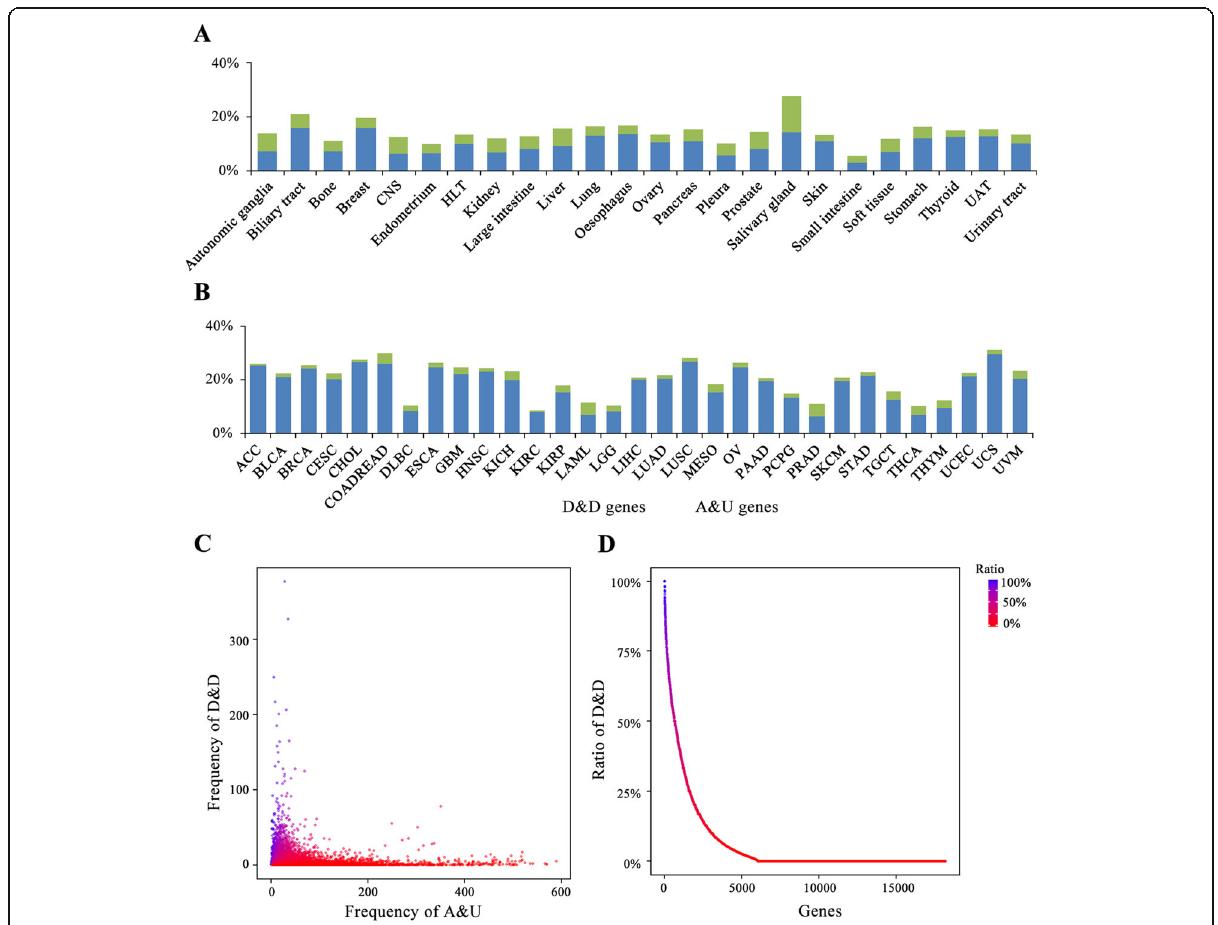
Fig. 3 Comprehensive analysis of concordance between CNV and differential gene expression. a. The count ratio of copy number amplification and expression level upregulation (Blue), copy number deletion and expression level downregulation (Green) of the total variant copy number count across each primary site of cell lines in CCLE. CNS: central nervous system; HLT: haematopoietic and lymphoid tissue; UAT: upper aerodigestive tract. b. The count ratio of copy number amplification and expression level upregulation (Blue), copy number deletion and expression level downregulation (Green) of the total variant copy number count across each cancer type of TCGA. c. Scatter plot shows the distribution of 18,174 genes based on the frequency of copy number amplification and expression level upregulation (x-axis) and the frequency of copy number deletion and expression level downregulation (y-axis) among 9159 tumor samples in TCGA. The color represents the count ratio of copy number deletion and expression level downregulation against copy number amplification and expression level upregulation, blue representing higher ratio of copy number deletion and expression level downregulation, red representing higher ratio of copy number amplification and expression level upregulation. d. Genes were sorted according to the count ratio of copy number deletion and expression level downregulation against copy number amplification and expression level upregulation among 9159 tumor samples in TCGA. A&U: copy number amplification and expression level upregulation. D&D: copy number deletion and expression level